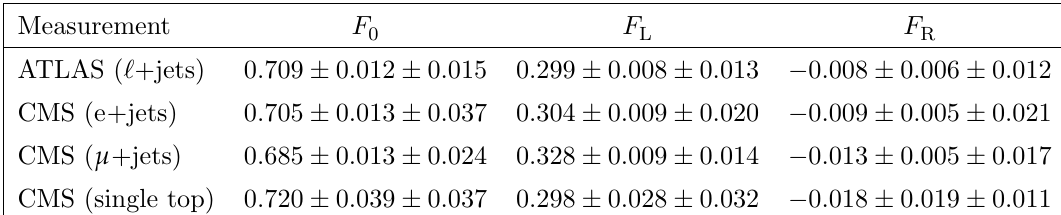
Table 1 . Summary of the published ATLAS and CMS measurements for 8 TeV data. The (cid:12)rst quoted uncertainty in the ATLAS measurement includes statistical uncertainties and uncertainties in the background determination, and the second uncertainty refers to the remaining systematic contribution. For CMS measurements, the (cid:12)rst uncertainty is statistical while the second is the total systematic uncertainty, including that on background